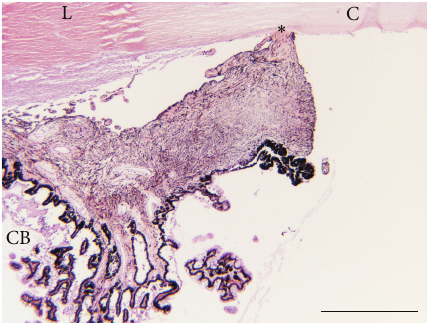
Figure 2: Horse A. The iris is markedly blunted and focally adhered to Descemet’s membrane (peripheral anterior synechia) (asterisk).Fororientation,C:cornea,L:limbus,andCB:ciliarybody. Hematoxylin and eosin. Bar = 2